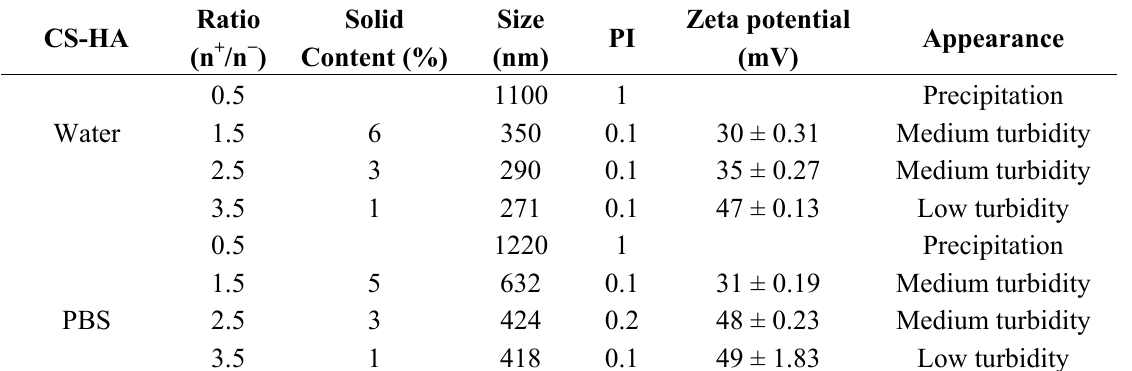
Table 2. Physicochemical characteristics of colloidal PECs after synthesis at different charge ratios. Chitosan (DA 48%, Mw 130 × 10 3 g/mol) and hyaluronic acid (Mw 50 × 10 3